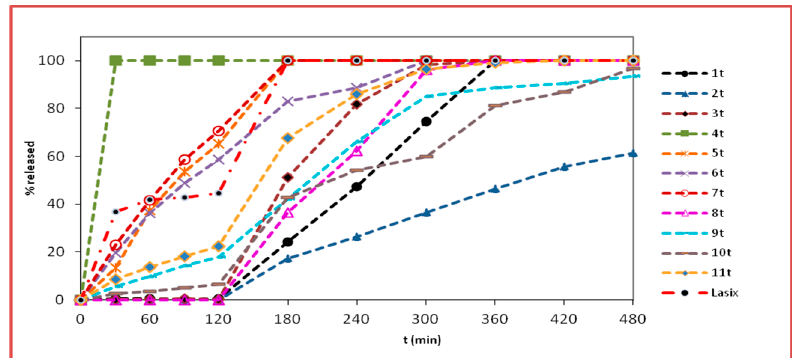
Figure 6. % release (mean values, n = 3) (SD < 2) vs. time (min) of furosemide from the physical mixture matrix tablets (formulations 1t–11t) and the commercially available product (Lasix ® ), at pH 1.2 (0–120 min) and at pH 6.8 (120–300 min).